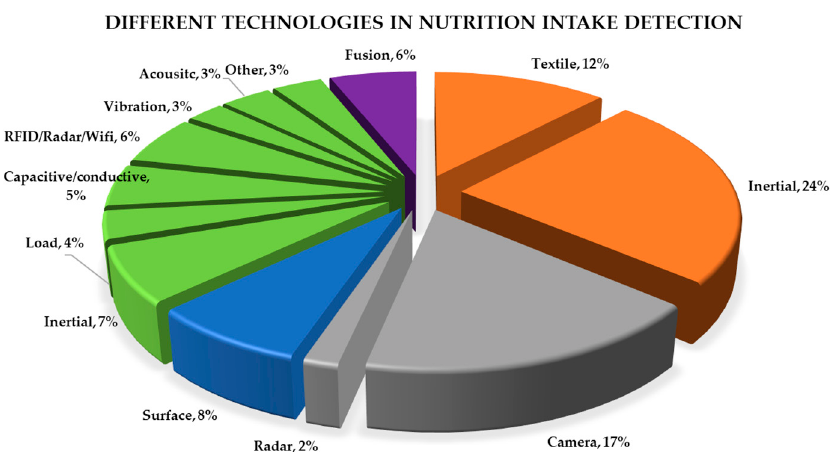
Figure 3. Breakdown of liquid intake monitoring approaches based on the technology used. Orange represents wearables, purple is fusion, green is smart containers, blue is surfaces with embedded sensors, and gray is vision- and environmental-based approaches.